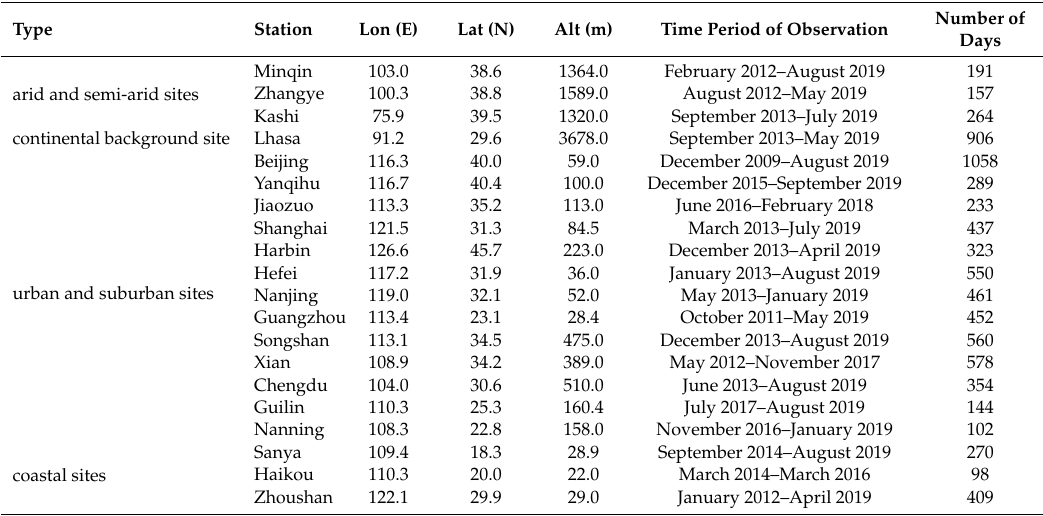
Table 1. Overview of the Sun–Sky Radiometer Observation Network (SONET) long-term stations and corresponding time period of